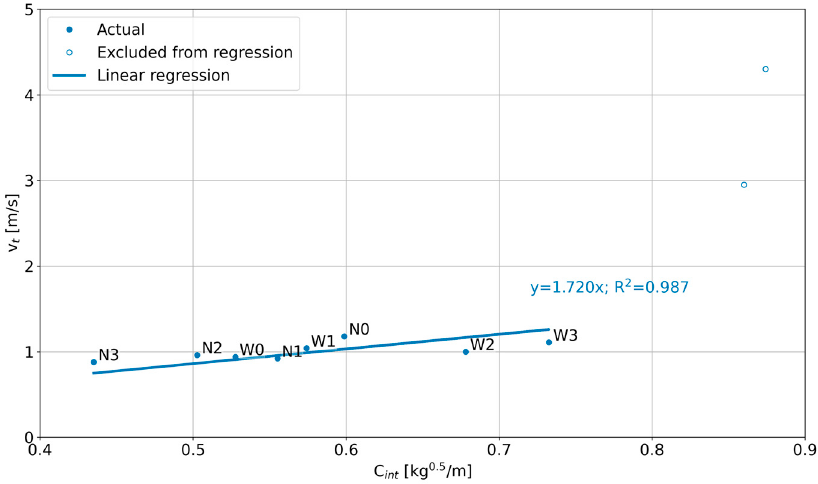
Figure 2. Sycamore seed results. Terminal velocity, v t , is plotted as a function of intrinsic component, C int . Actual data points are shown as well as linear regression line covering data for samples N0 – N3 and W0 – W3 .